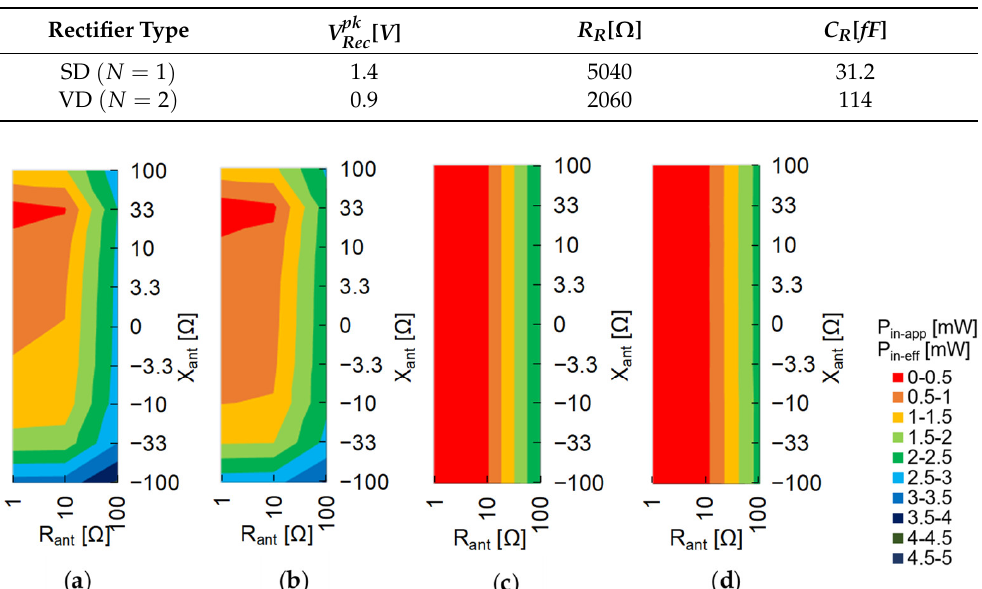
Table 3. V pk , R R , C R for each rectifier candidate at I out = 100 µ A and V out = 1 V. Rec